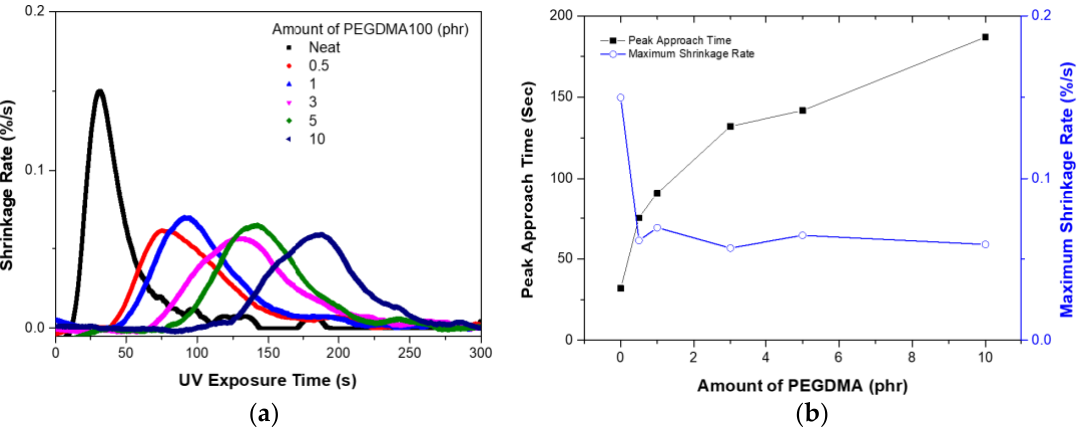
Figure 11. Analysis of shrinkage rate of a UV-curable system using PEGDMA100: ( a ) shrinkage rate; ( b ) peak approach time and maximum shrinkage rate.